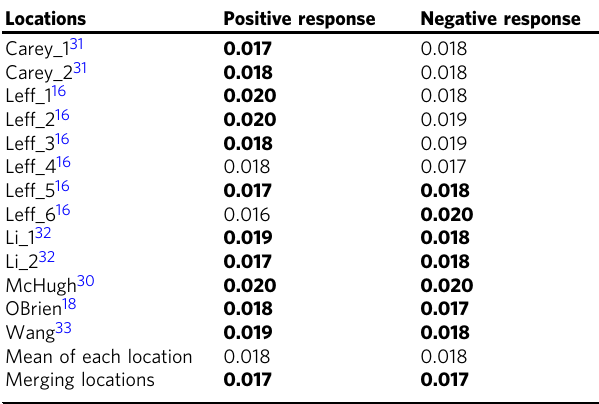
Table 2 Mean genetic depth ( τ D ) of consensus clades as calculated with the consenTRAIT algorithm Locations